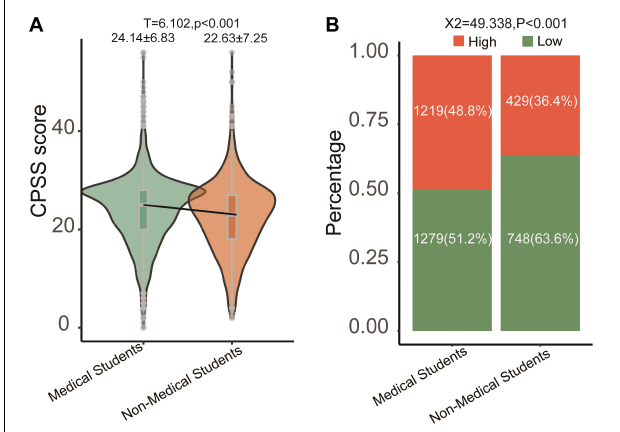
FIGURE 2 | Comparison of medical students with non-medical students. (A) Continuous CPSS score; (B) category CPSS score (high > 25 vs. low ≤